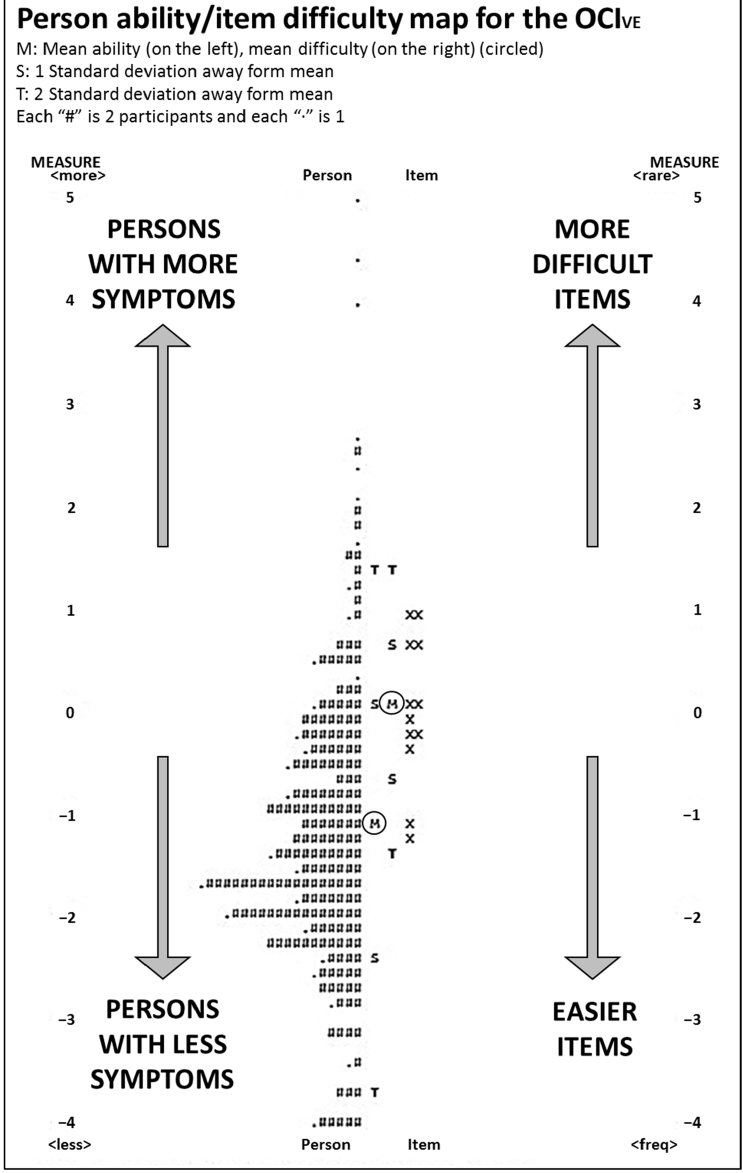
Figure 2. Person ability/item difficulty map for the OCI VE . The person (symbolized left of the vertical line) and item (symbolized to the right of the vertical line) appear in a descending order of ability and difficulty, respectively, on a scale that represents the logit value of ocular comfort, as transformed from the Rasch analysis. Responses involving higher scores of ocular discomfort (more symptomatic persons) and those items awarded lower scores (harder items) appear at the top of the scale, whereas responses involving lower scores of discomfort and easier items appear at the bottom.